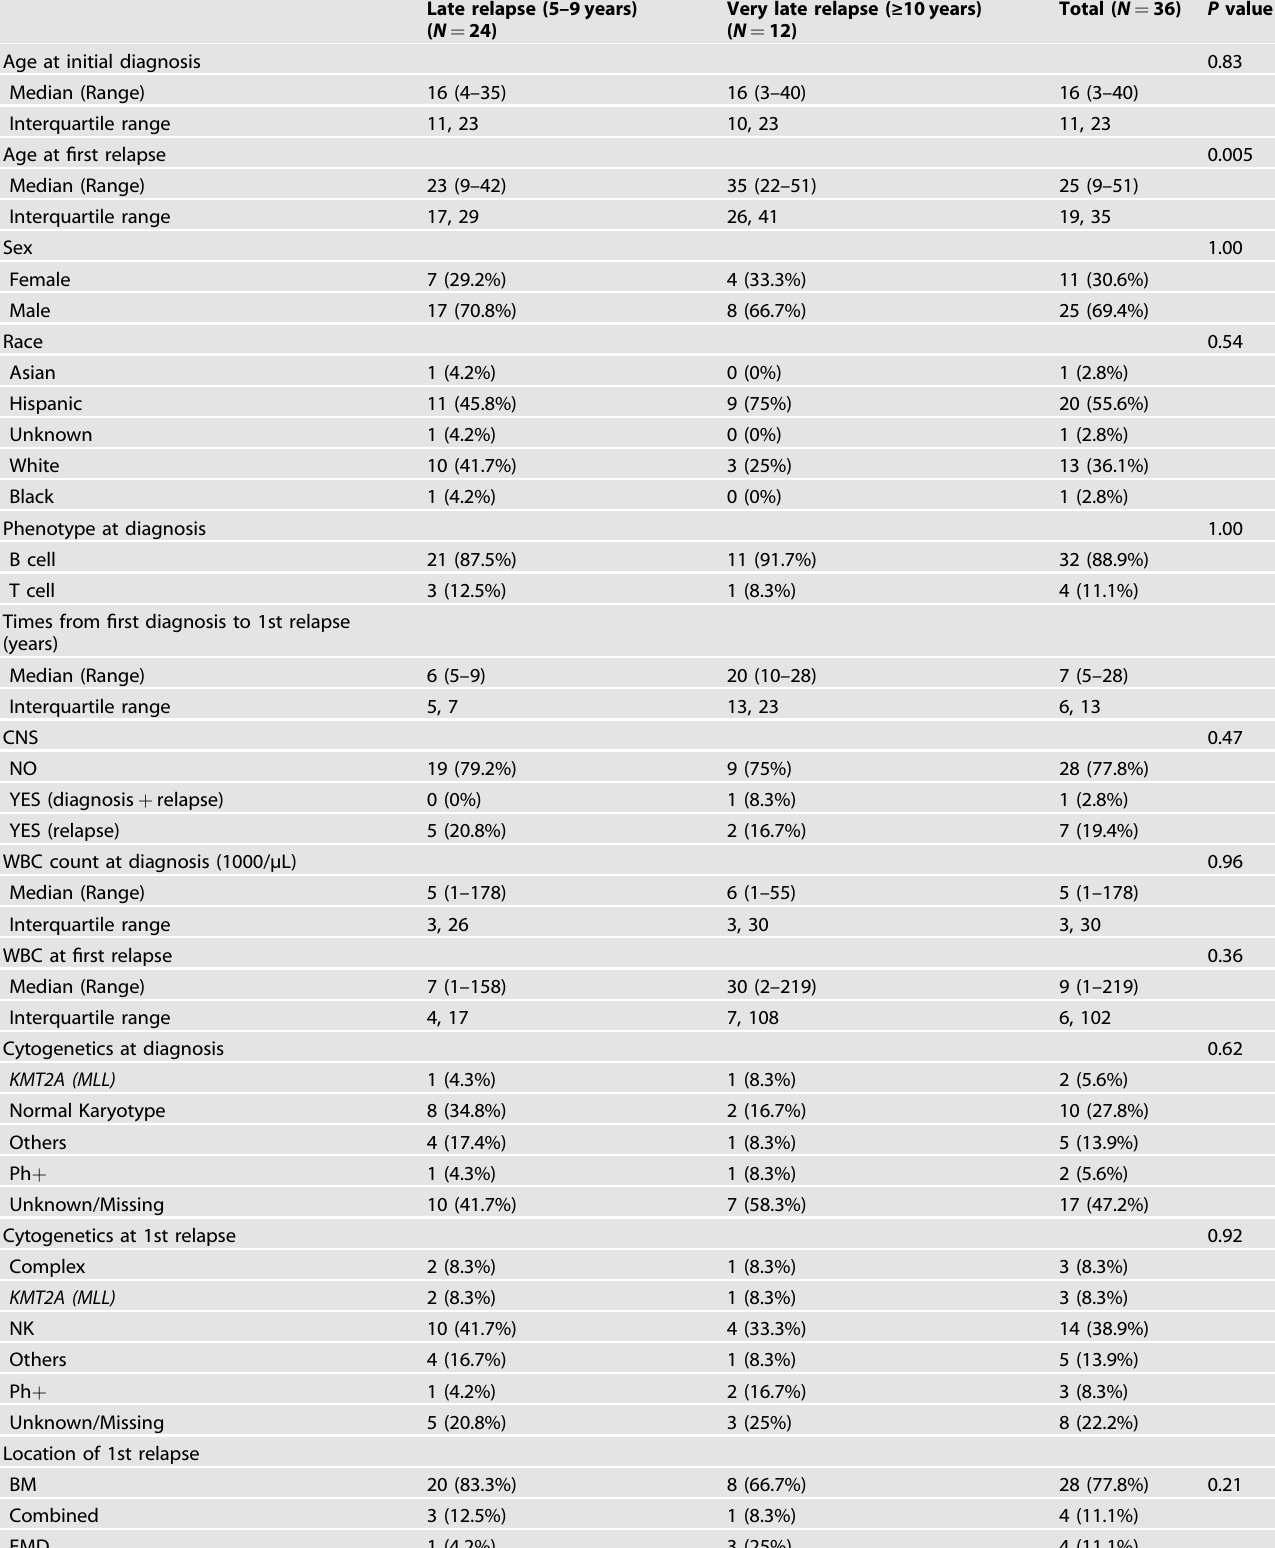
Table 1. Patient and leukemia